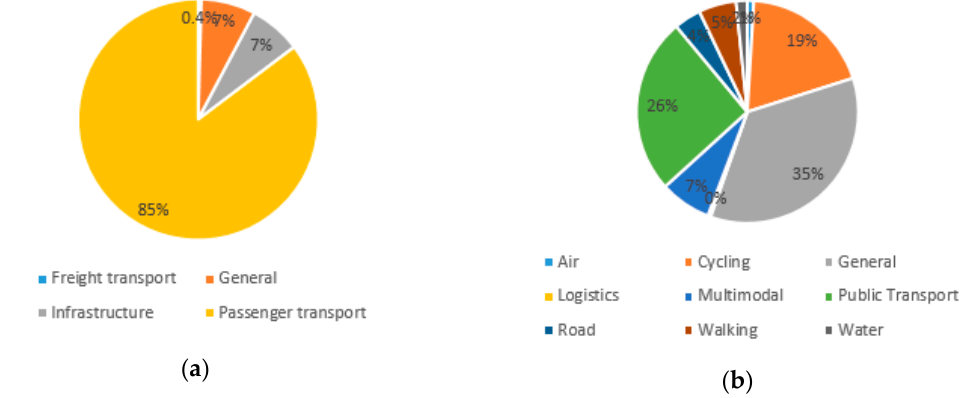
Figure 3. Subjects studied: ( a ) Analysis of the transport projects per main categories; ( b ) Transport projects sub-category distribution.